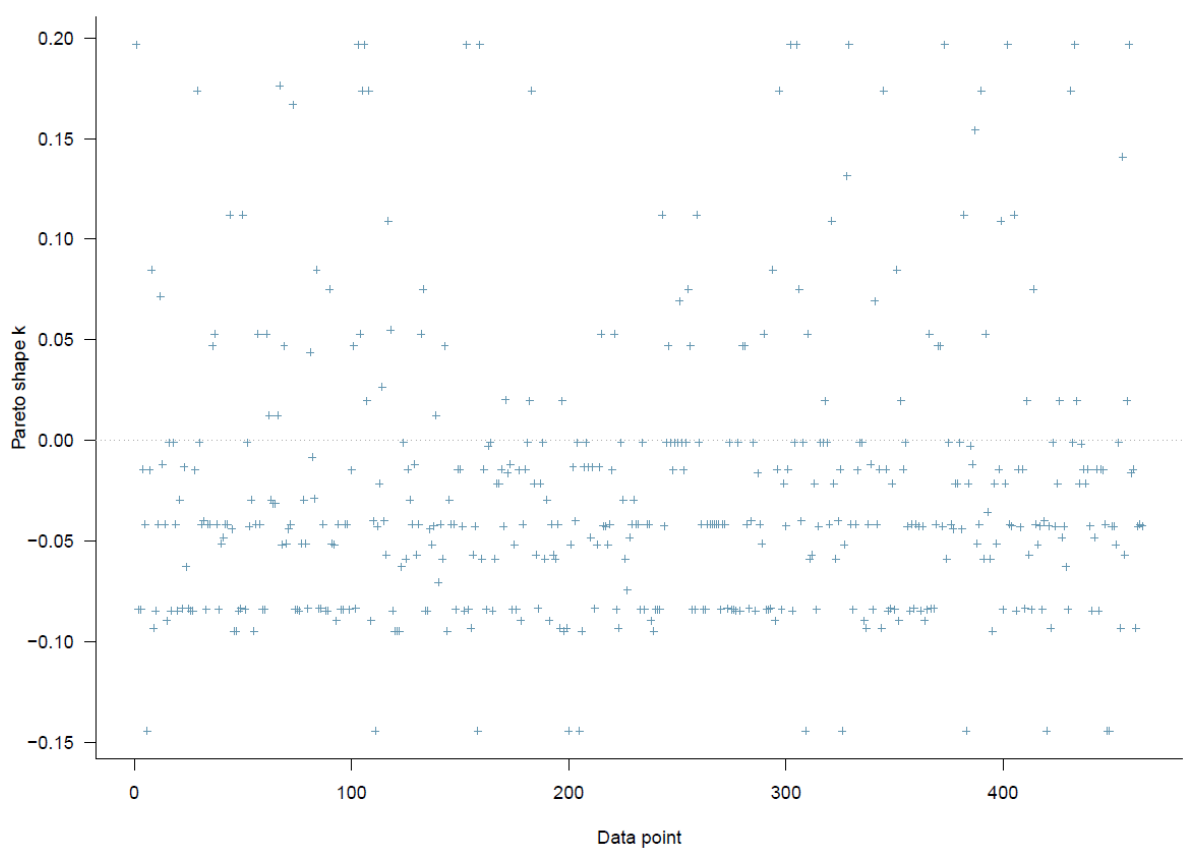
Figure 2. Model 1 (cid:48) s PSIS diagnostic plot. Figure 2. Model 1′s PSIS diagnostic plot. The diagnostic statistics portray a good convergence of the model’s Markov chains because the effective sample sizes (n_eff) are larger than 1000, and Gelman shrink factor (Rhat) statistics are equal to 1 (see Table 2). The trace plots, autocorrelation plots, and Gelman plots also confirmed the good convergence of the model. Table 2. Model 1 (cid:48) s simulated posterior coefficients. Table 2. Model 1′s simulated posterior coefficients.